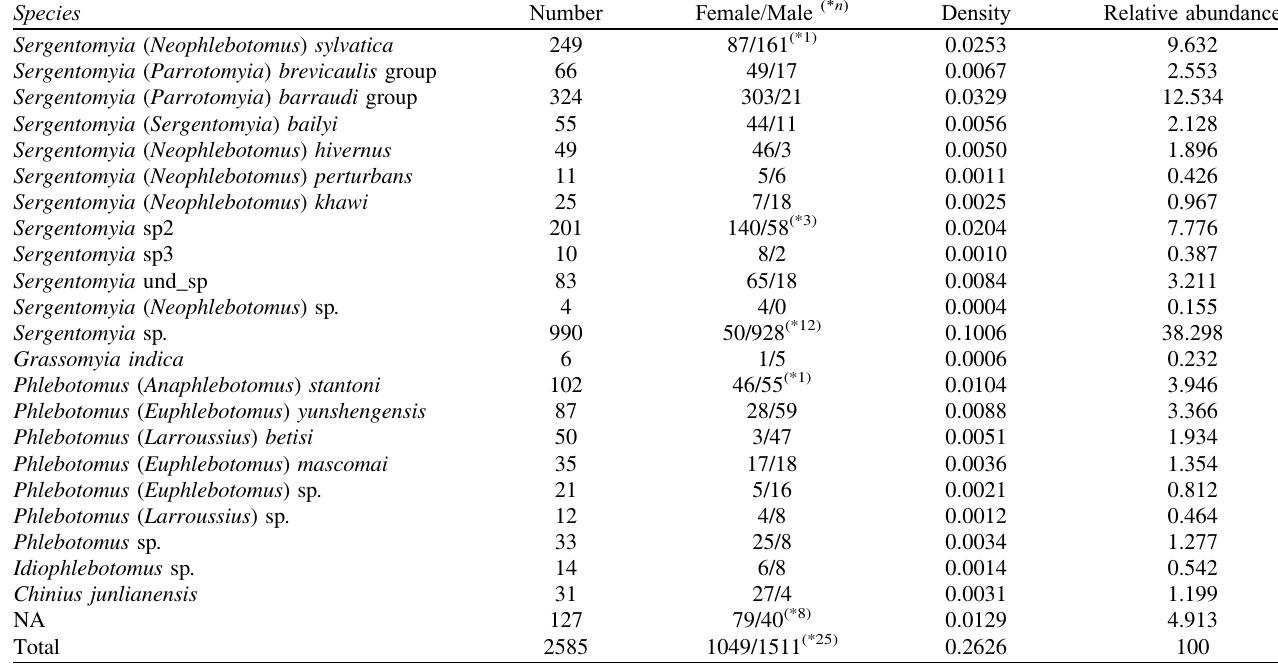
Table 1. Number of specimens per taxon, sex ratio, density and relative abundance according to the taxa.